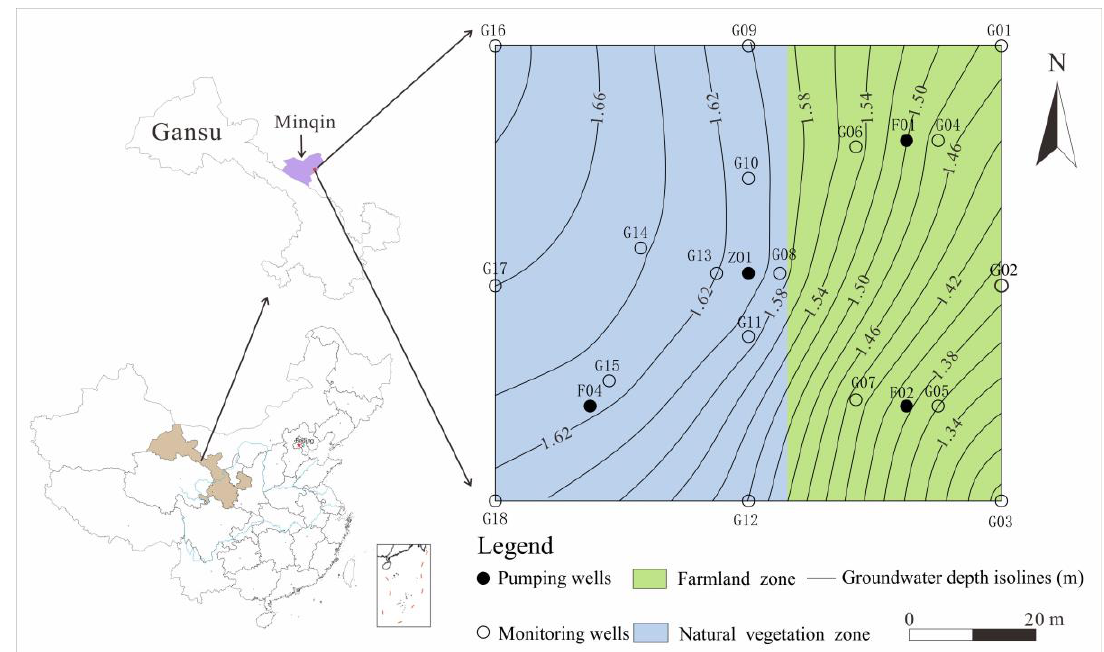
Figure 1. Map showing the contours of phreatic water depth and the distribution of monitoring wells under no control measures.